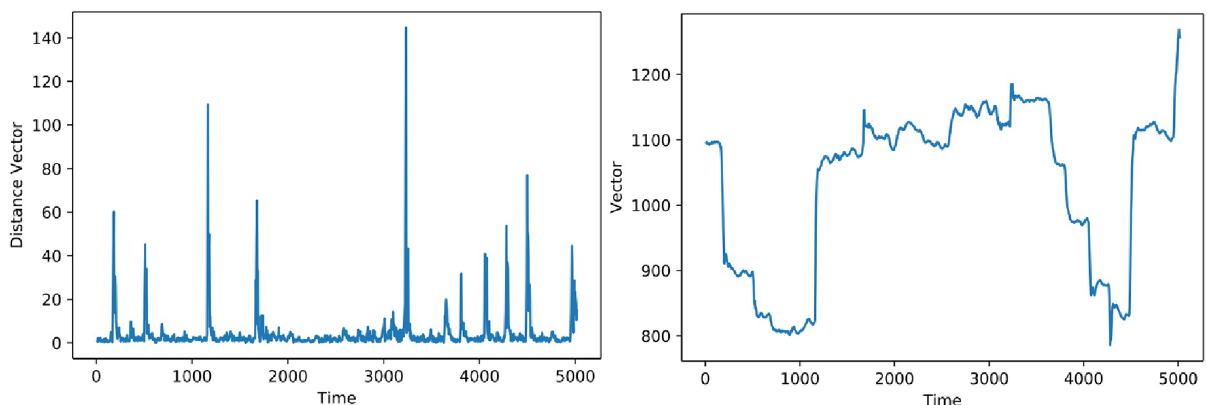
Fig 4. Time series illustrating distance vector’s suitability for time series analysis compared to vector. The vector versus time plot has constant amplitude effect and does not show participant’s perfect gaze behaviour in relation to the region of interest (ROI).